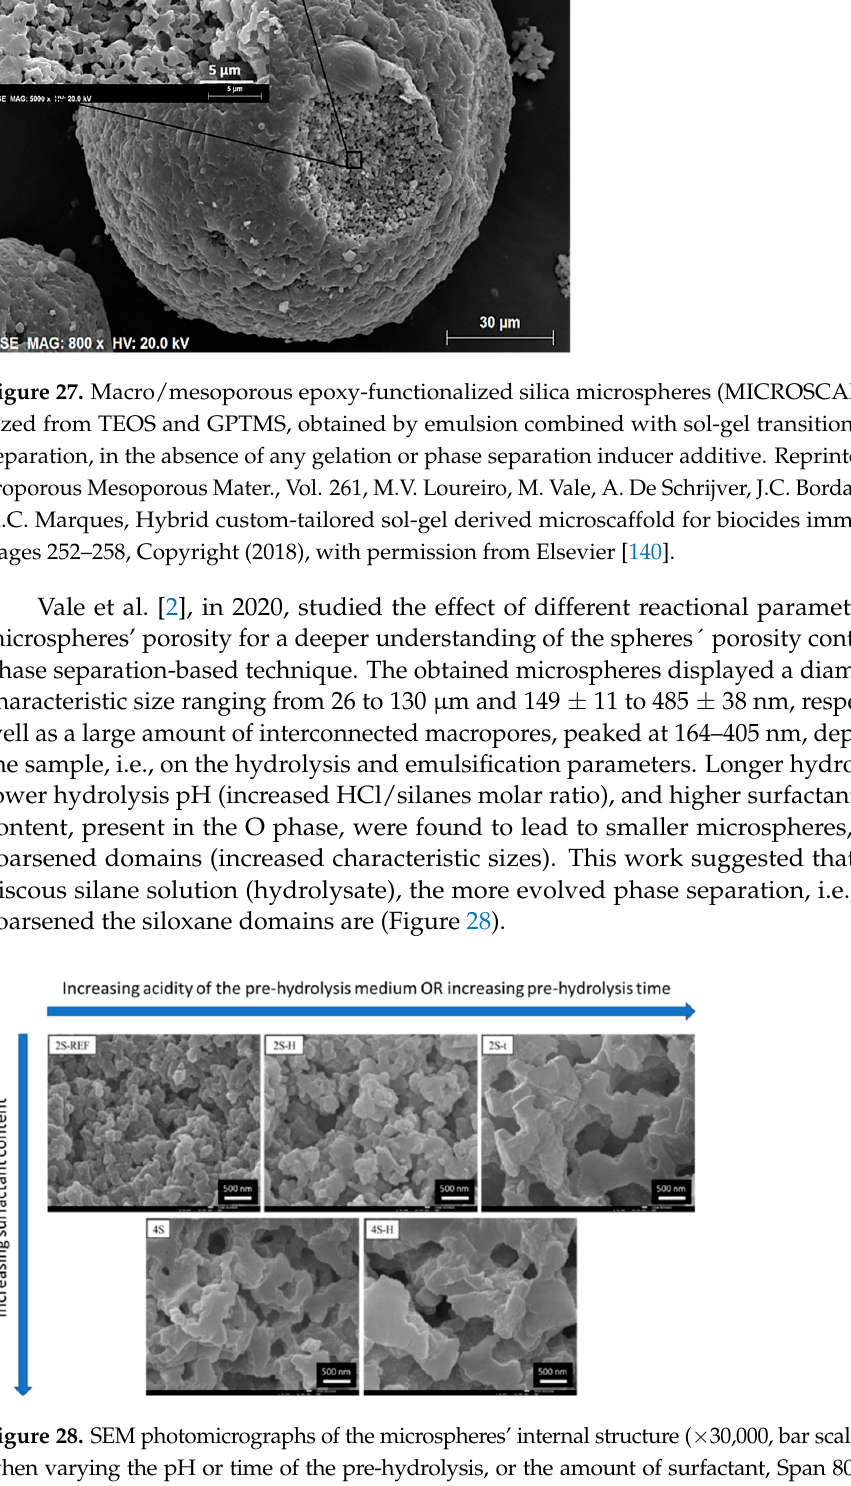
Figure 28. SEM photomicrographs of the microspheres’ internal structure (×30,000, bar scale = 500 nm), when varying the pH or time of the pre-hydrolysis, or the amount of surfactant, Span 80, present in the O phase of the emulsion. Reprinted by permission from Springer: Springer Nature, Journal of Sol-Gel Science and Technology, Silica-based microspheres with interconnected macroporosity by phase separation, M á rio Vale, M. V. Loureiro, M. J. Ferreira, A. C. Marques [2] Copyright Springer Nature